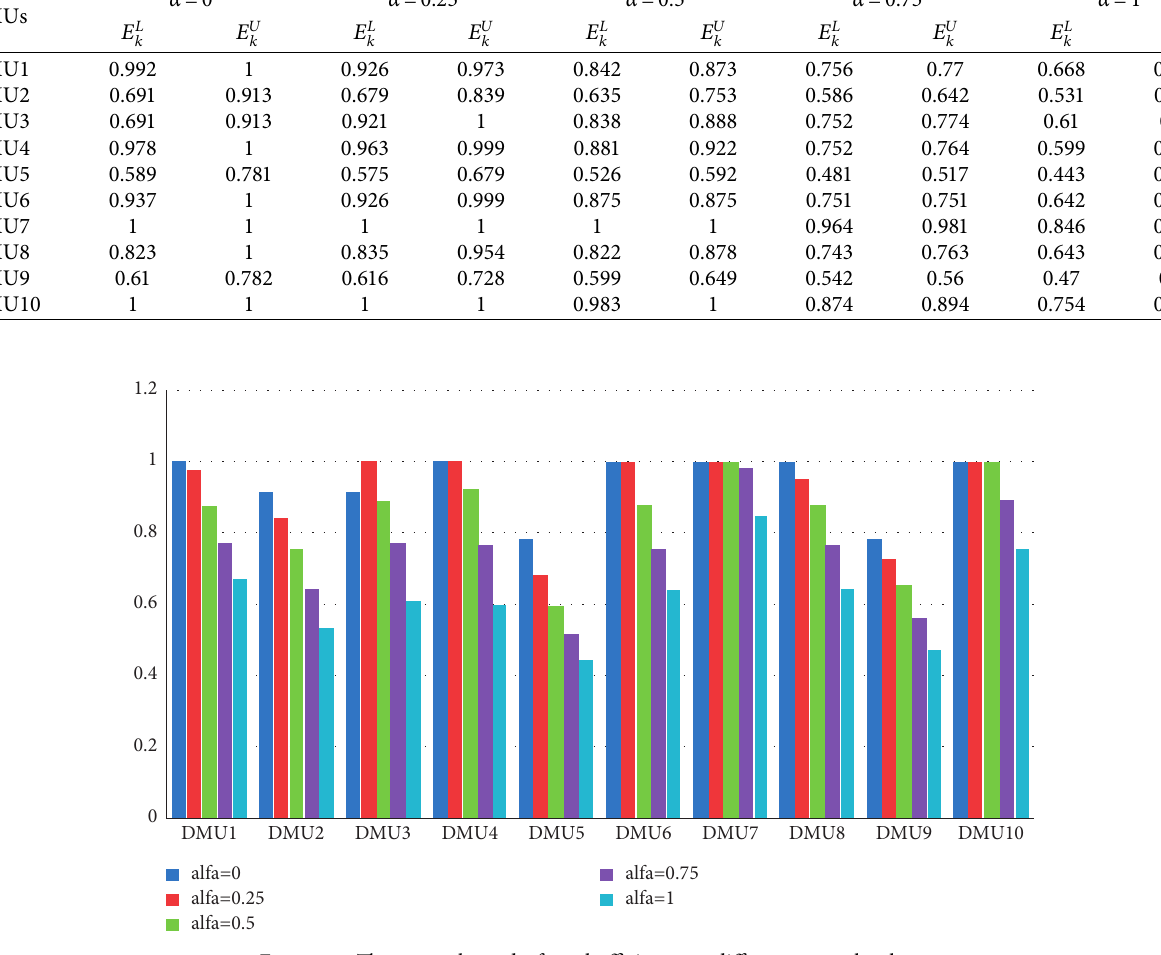
Figure 5: The upper bound of total efficiency at different α -cut levels.